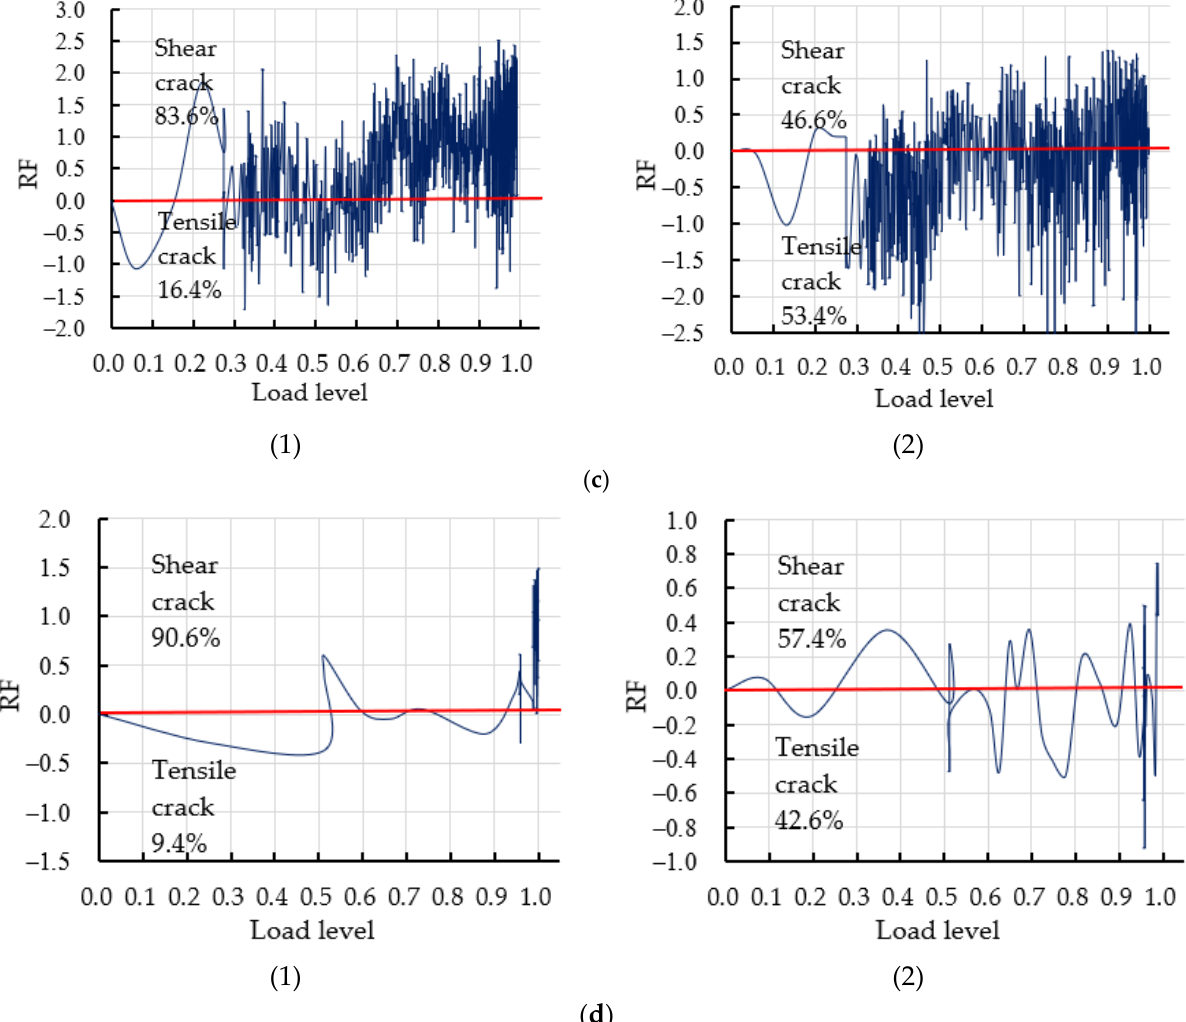
Figure 10. The variation curve of RF: ( a ) RPC; ( b ) SBRPC-1; ( c ) SBRPC-3; ( d ) SBRPC-5.